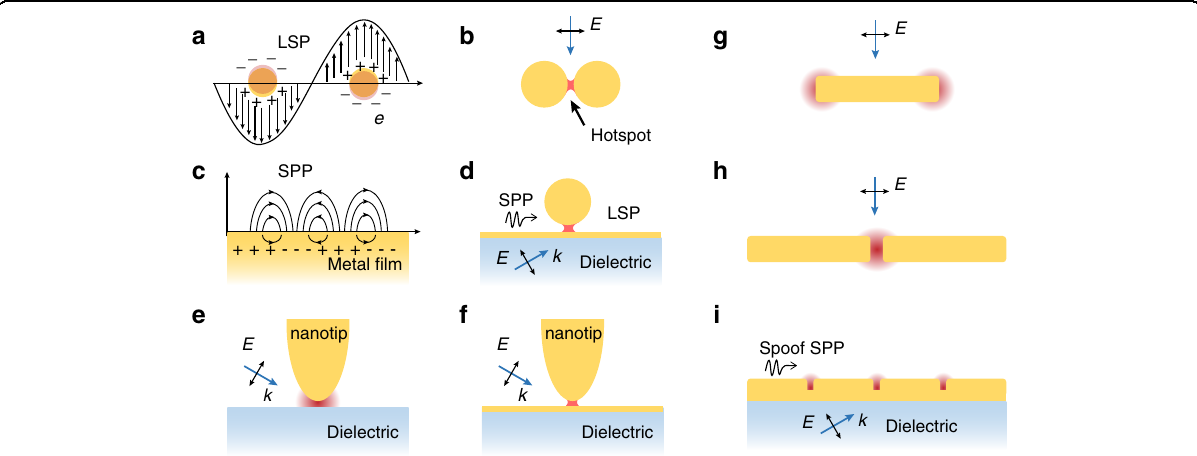
Fig. 4 SERS and SEIRA-active nano/microstructures. a A single nanoparticle supporting a LSP, and b a nanoparticle dimer with a nanogap supporting a coupled LSP. c A metal fi lm supporting a SPP, and d a particle-on- fi lm coupled structure supporting the SPP-LSP coupling. e A nanotip supporting LSP and acting as a lightning rod, and f a nanotip- fi lm coupled structure. g A nanorod, h A nanorod dimer. i A metal strip with periodic grooves supporting a SPP in IR region, which is called a spoof spp. a – f the substrates for SERS, g – i the substrates for